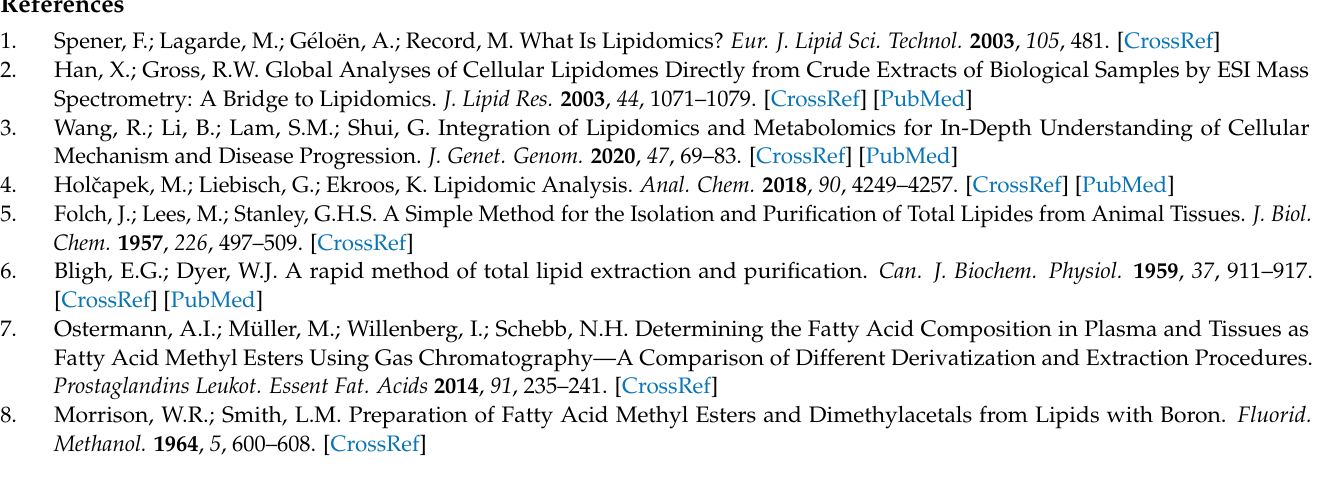
Figure S3: (a) Contour plot of FAMEs standard mixture. (b) Zoomed-in contour plot of FAMEs standard mixture, Figure S4: (a) Contour plot of NIST SRM 1950 standard. (b) Zoomed-in contour plot of NIST SRM 1950 standard, Figure S5: (a) Contour plot of pig serum. (b) Zoomed-in contour plot of pig serum, Table S1: Fatty acid composition (% Area) of boar-tainted (BT, n = 20) and untainted (UT, n = 20) pig